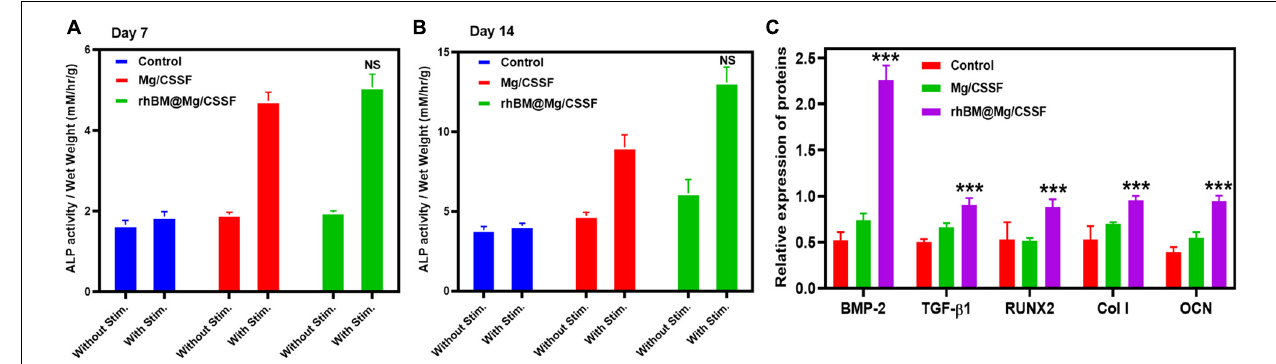
FIGURE 7 | Analysis of osteogenic differentiation efficacy of rBMSCs on injectable hydrogel groups. (A,B) Alkaline phosphatase (ALP) activity at different incubation times of 7 and 14 days, respectively. (C) Quantitative analysis of osteogenic gene expressions of rBMSCs seeded on hydrogel groups at day 14 of the culture period